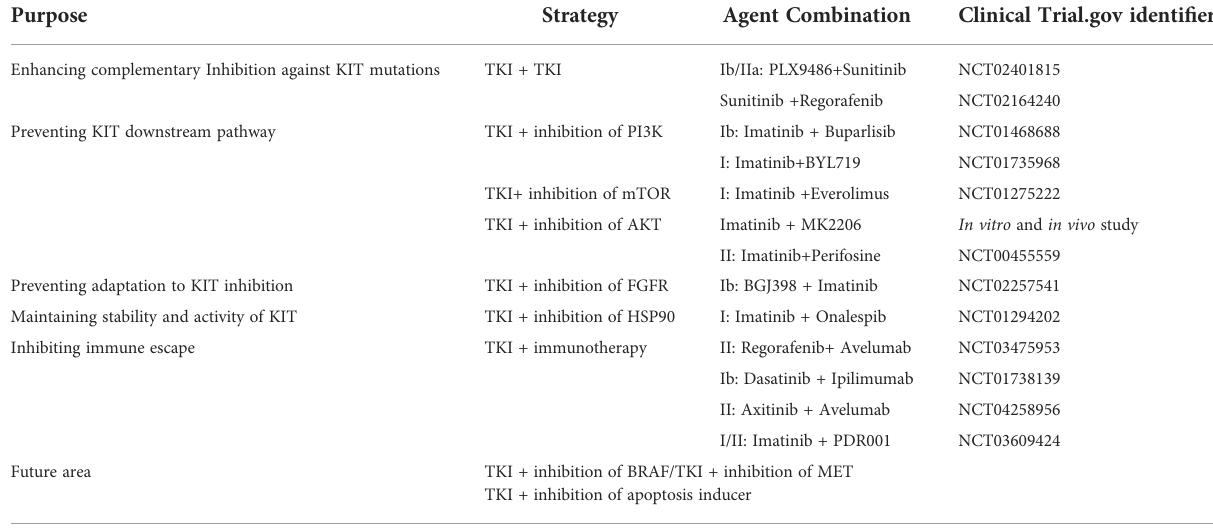
TABLE 3 Agent combination based on different strategies in the treatment of Imatinib-resistant